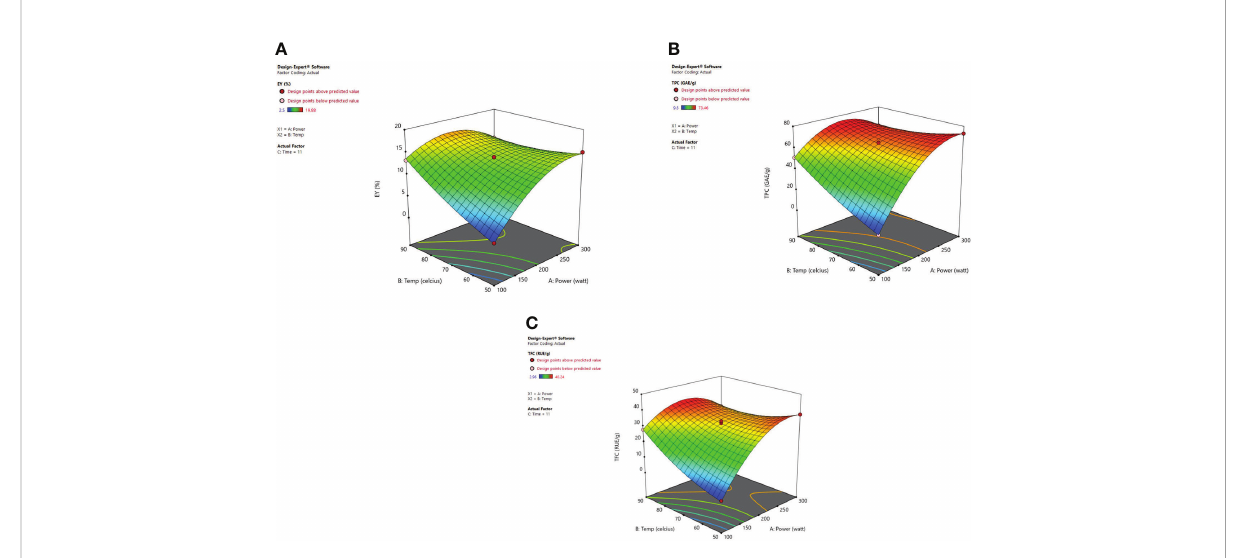
FIGURE 4 3-D diagrams indicating the effect of different variables (X 1 , X 2 ) on response, (A) EY (Y 1 ), (B) TPC (Y 2 ), (C) TFC (Y 3 ) in MAE.